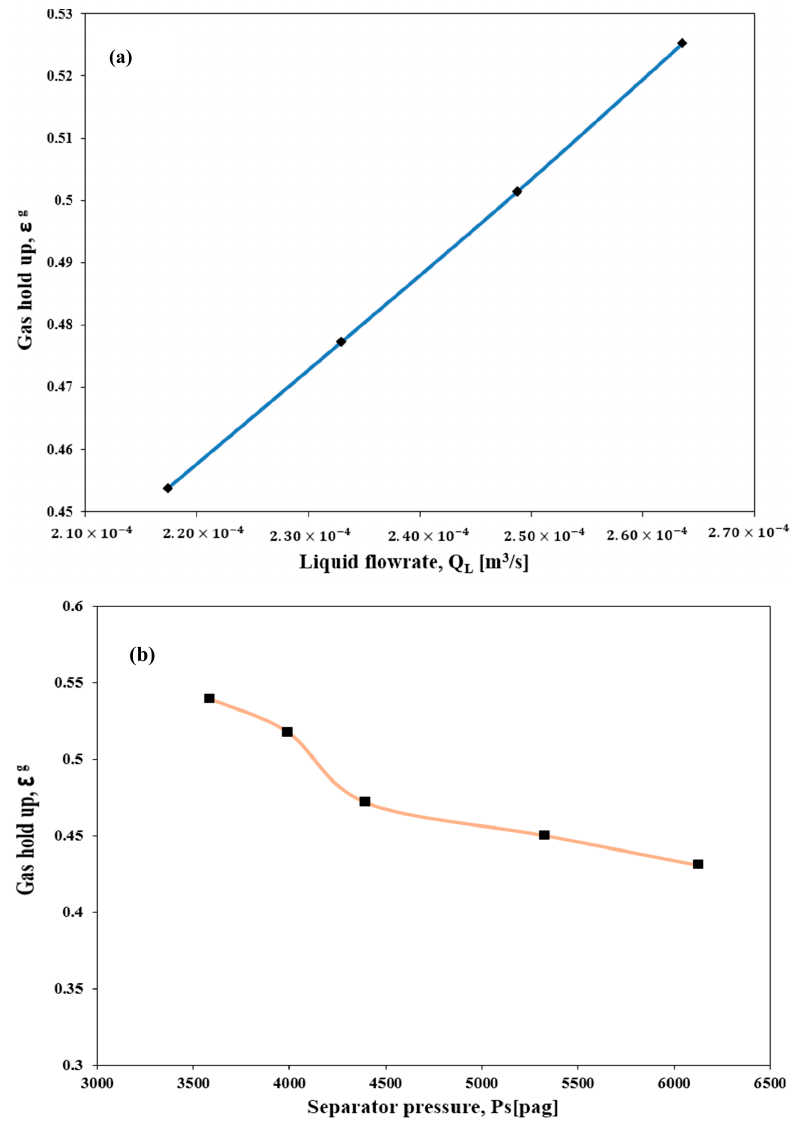
Figure 5. ( a ) The effects of liquid flow rate (Q L ) on gas phase hold-up ( ε g ) for nozzle diameter = 6 mm and pressure outlet = 3250 Pag ( b ) The effects of separator pressure (Ps) on gas phase hold-up ( ε g ) at a constant liquid flow rate of 2.85 × 10 − 4 m 3 /s for the air–water system (nozzle diameter = 6 mm).